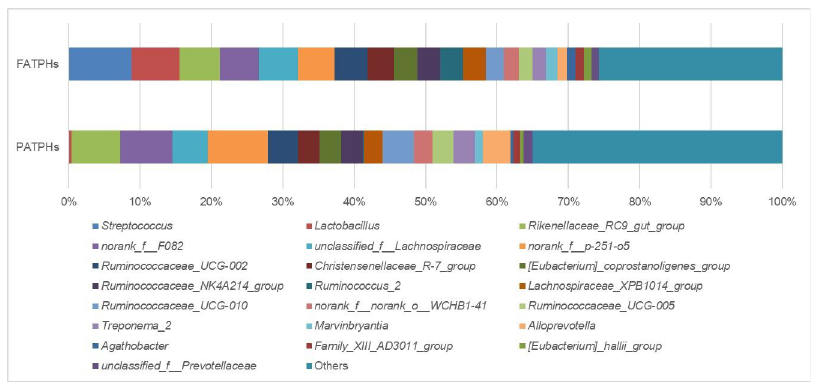
Fig 3. Top relative abundances of genera ranked by 0 order of magnitude and higher based on the FATPHs with relative abundances of the corresponding genera in the PATPHs shown. The relative abundances of the rest genera were grouped as